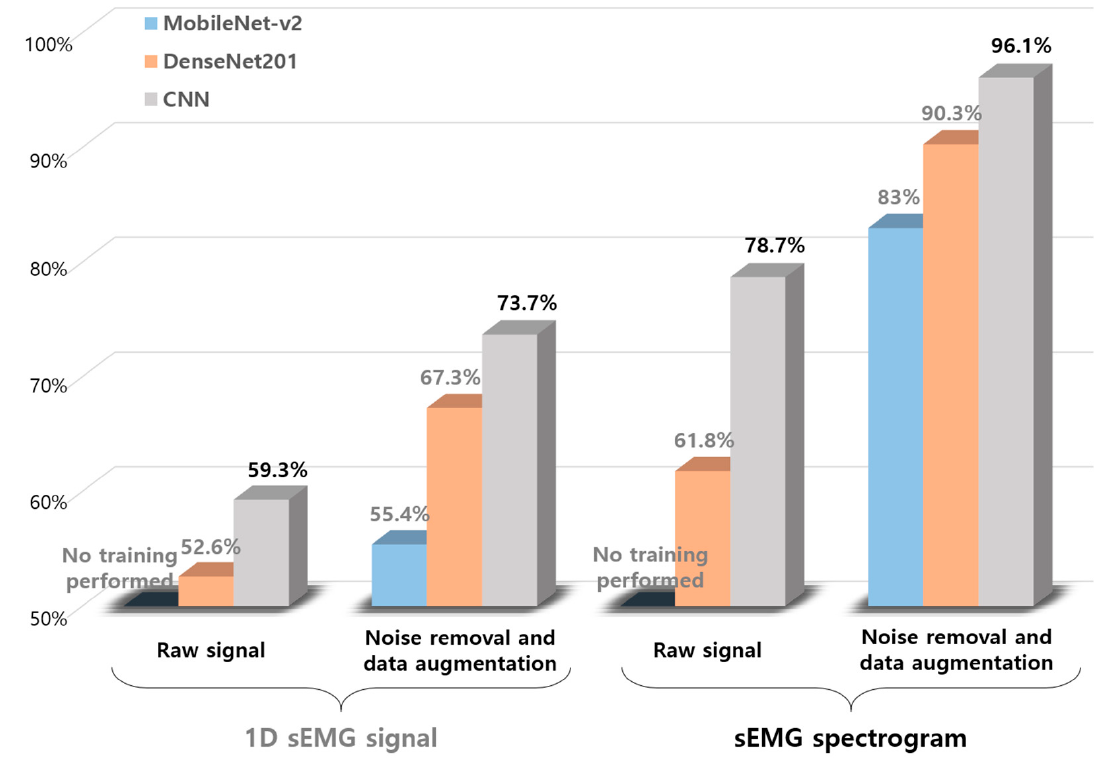
Figure 14. User identification performance comparison.